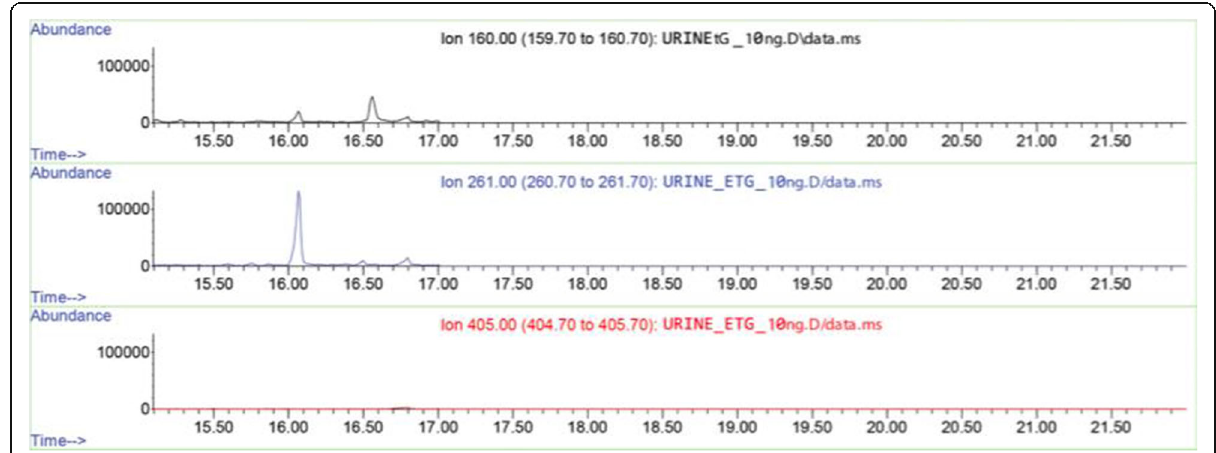
Fig. 3 Reconstructed ion chromatogram of 10 ng/ml (LOD)